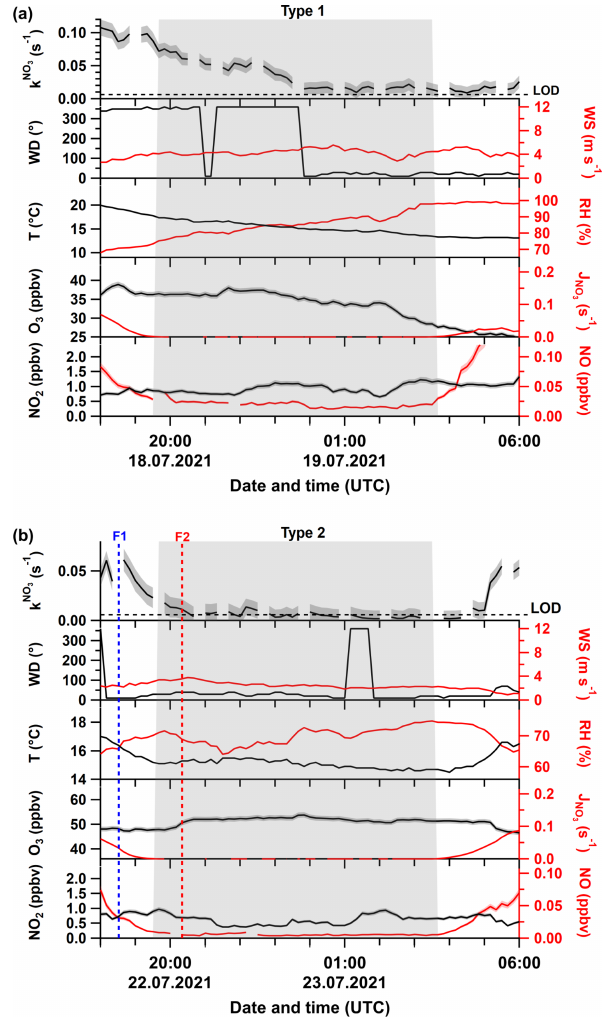
Figure 2. Time series of directly measured NO 3 reactivity ( k NO 3 ), together with auxiliary measurements during Type 1 (a) and Type 2 nights (b) . F1 and F2 mark times at which drone-assisted tempera- ture and relative humidity profiles were measured. The grey shaded area represents nighttime. Abbreviations are defined in the caption of Fig. 1. The shaded areas in the colour of the lines denote the corresponding uncertainty of the measured